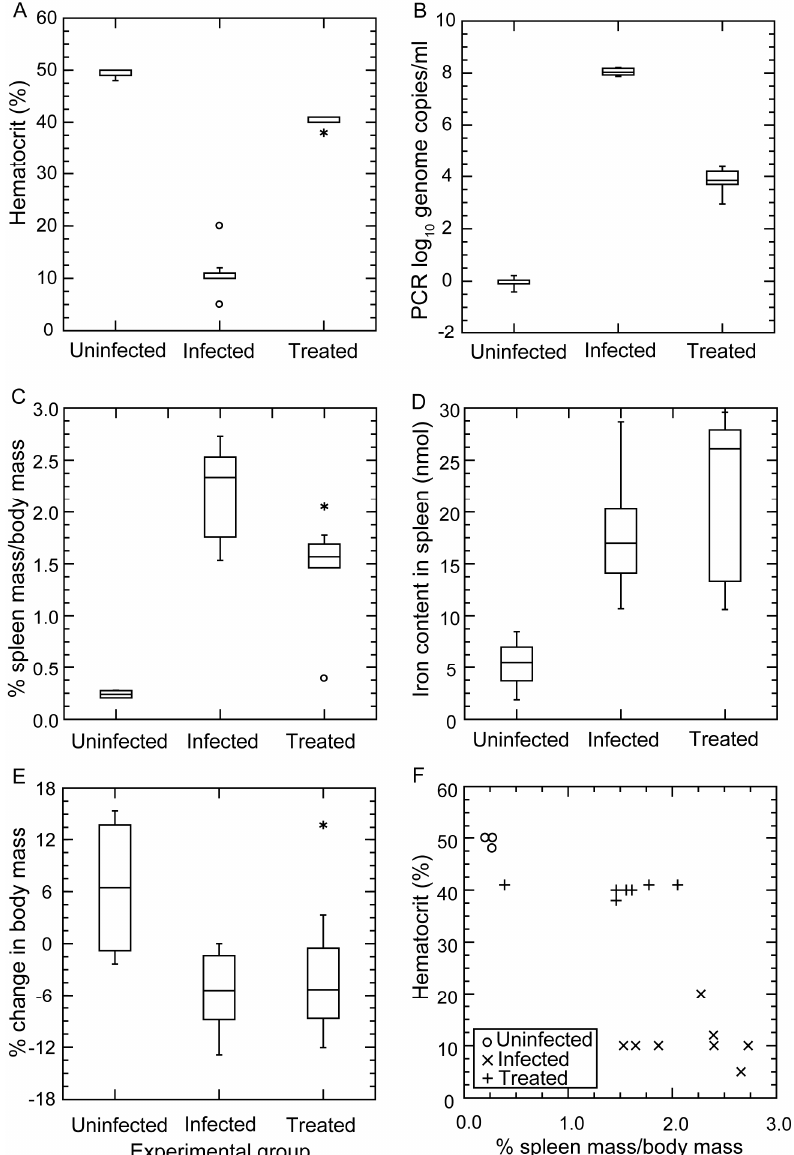
Figure 9. Severe anemia in BALB/c mice with severe combined immunodeficiency (SCID) and infected with strain CC1 of B. hermsii . The experiment is described in the accompanying text. Panels ( A – E ) are box-whisker plots in which each horizontal box indicates the first and third quartiles, and the indentation inside the box is the median. * The 1.5× interquartile range is indicated by the horizontal line (whiskers) bisecting the box, and values outside this range are indicated by asterisks and circles. The three conditions were uninfected (n = 4 mice), infected without antibiotics (n = 8), and infected with antibiotics (n = 7). Panel ( A ) is of the hematocrit values for the whole blood from the mice. Panel ( B ) is of the spirochete burdens in the groups of mice as estimated by qPCR as described for Figure 3; Panel ( C ) displays the ratios in percentages of the spleen weight to total body weight after euthanasia; Panel ( D ) shows the iron content in the spleen in nmol per gram of spleen; Panel ( E ) shows the net change in body mass in percentage between initial measurement and measurement at time of euthanasia; Panel ( F ) is a scatter plot of hematocrit values against ratio of spleen weight to body weight for individual mice in each